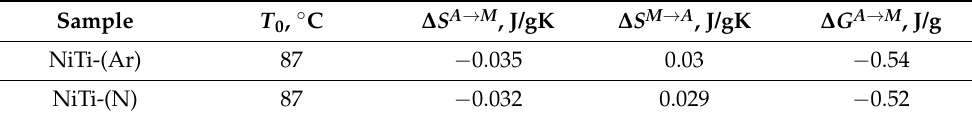
Table 3. Calculated values of thermodynamic parameters for porous NiTi-(Ar) and NiTi-(N) samples obtained by the SHS.